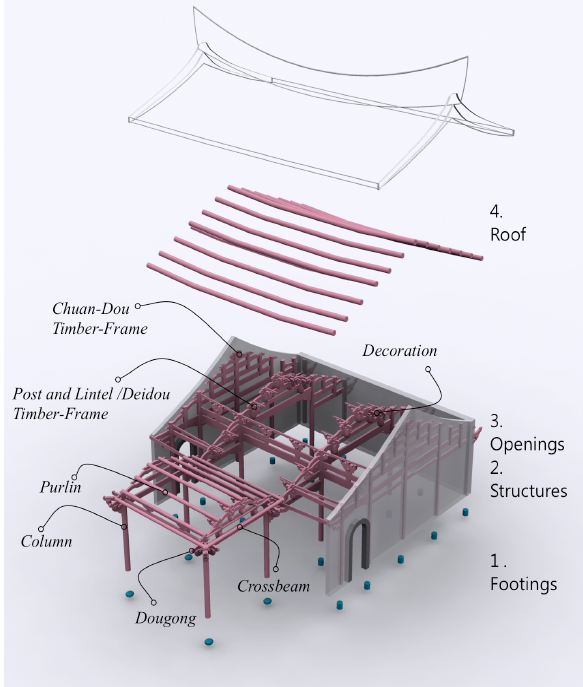
Figure 7. Parametric categories: 1. Footings and vertical structure; 2. Horizontal structure; 3. Openings; 4. Roof structure. Roof and wooden